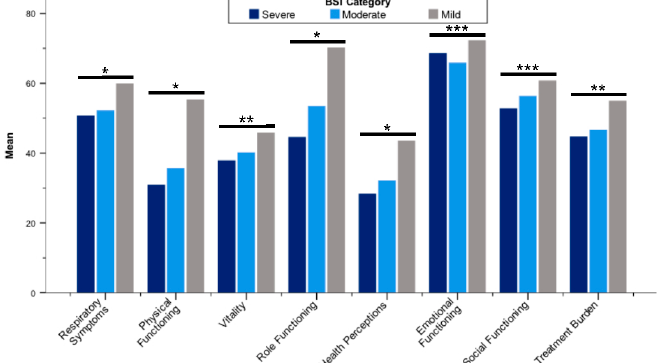
Figure 2. Mean Quality of Life Questionnaire-Bronchiectasis scores stratified by BSI categories. Abbreviation: BSI, Bronchiectasis Severity Index; * p < 0.001; ** p < 0.01; *** p < 0.05. Differences between groups were assessed by the Kruskal–Wallis test.